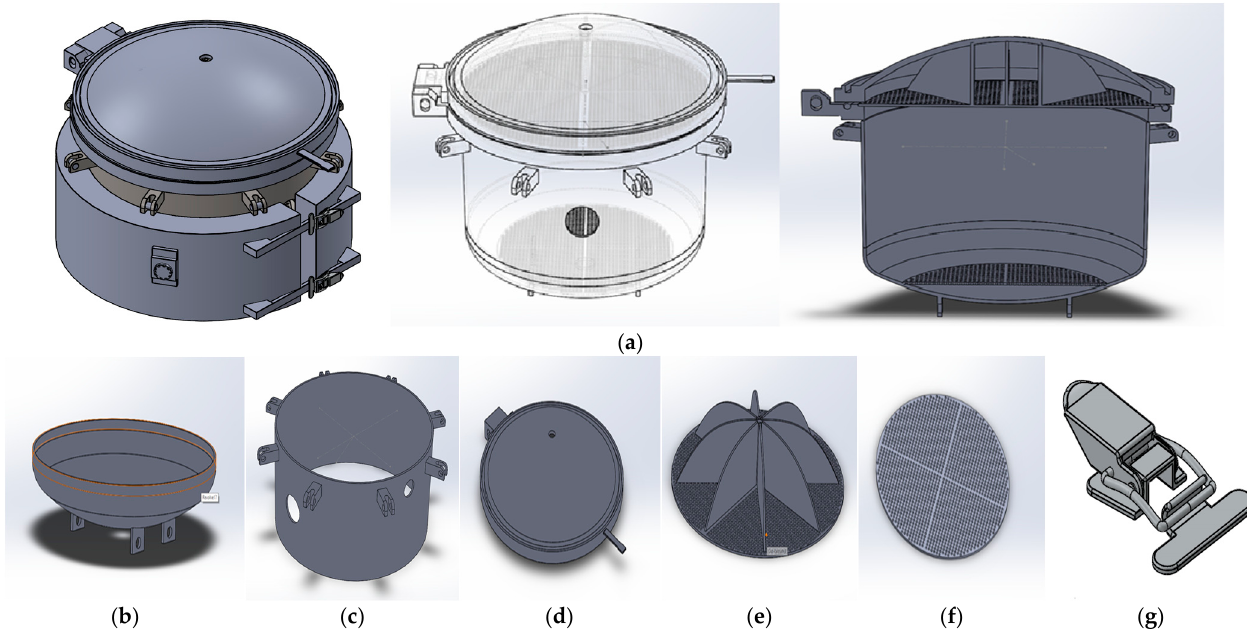
Figure 4. Extraction tank design, associated with the experimental pilot model: ( a ) overview of extraction vessel design, ( b ) upper cover, ( c ) main body, ( d ) lower body, ( e ) upper sieve, ( f ) lower sieve, and ( g ) locking clamp.